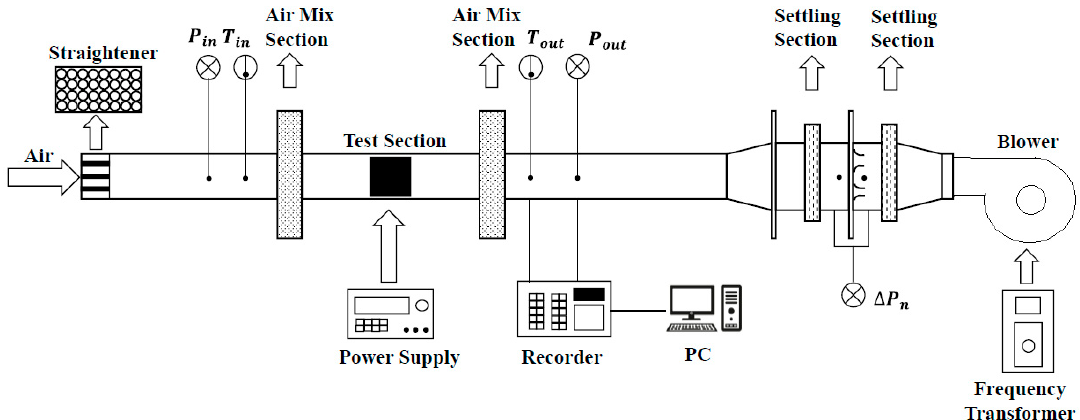
Figure 1. Schematic diagram of the wind tunnel in this study.